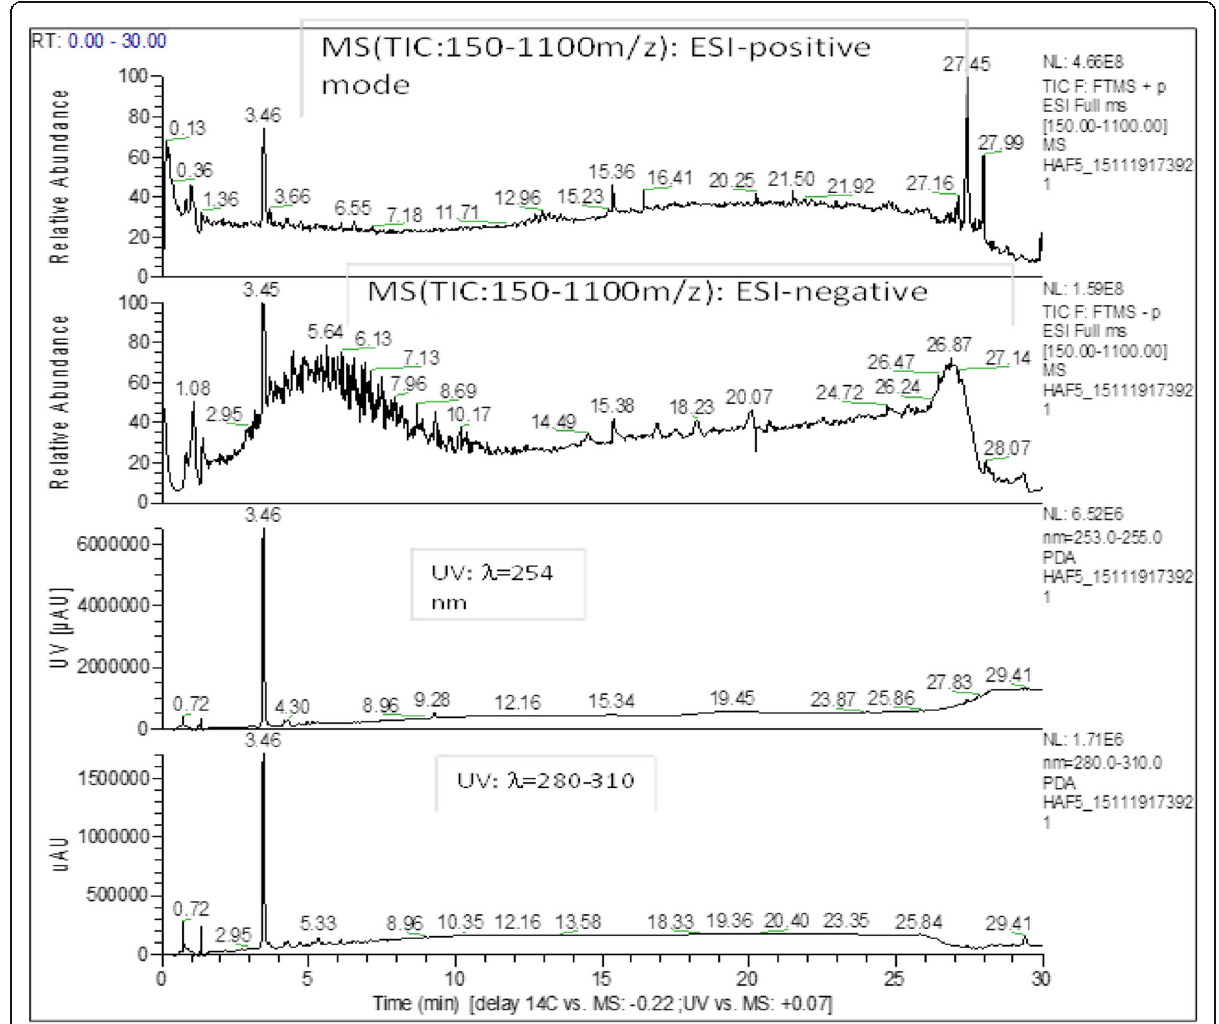
Fig. 2 Full scan chromatogram of the hydromethanolic extract of F.